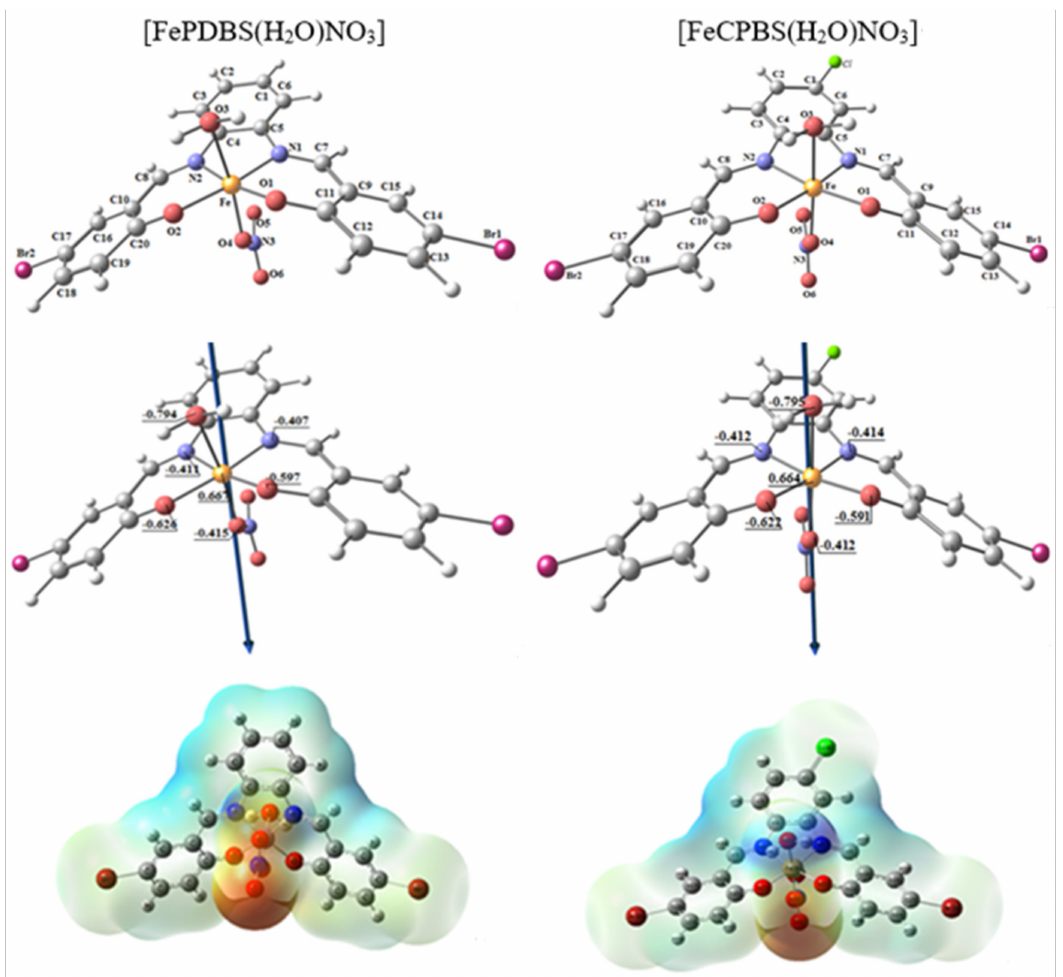
Figure 5. The natural charges on active centers of the optimized structures and molecular electrostatic potential (MEP) surface of [FePDBS(H 2 O)NO 3 ] and [FeCPBS(H 2 O)NO 3 ] complex.